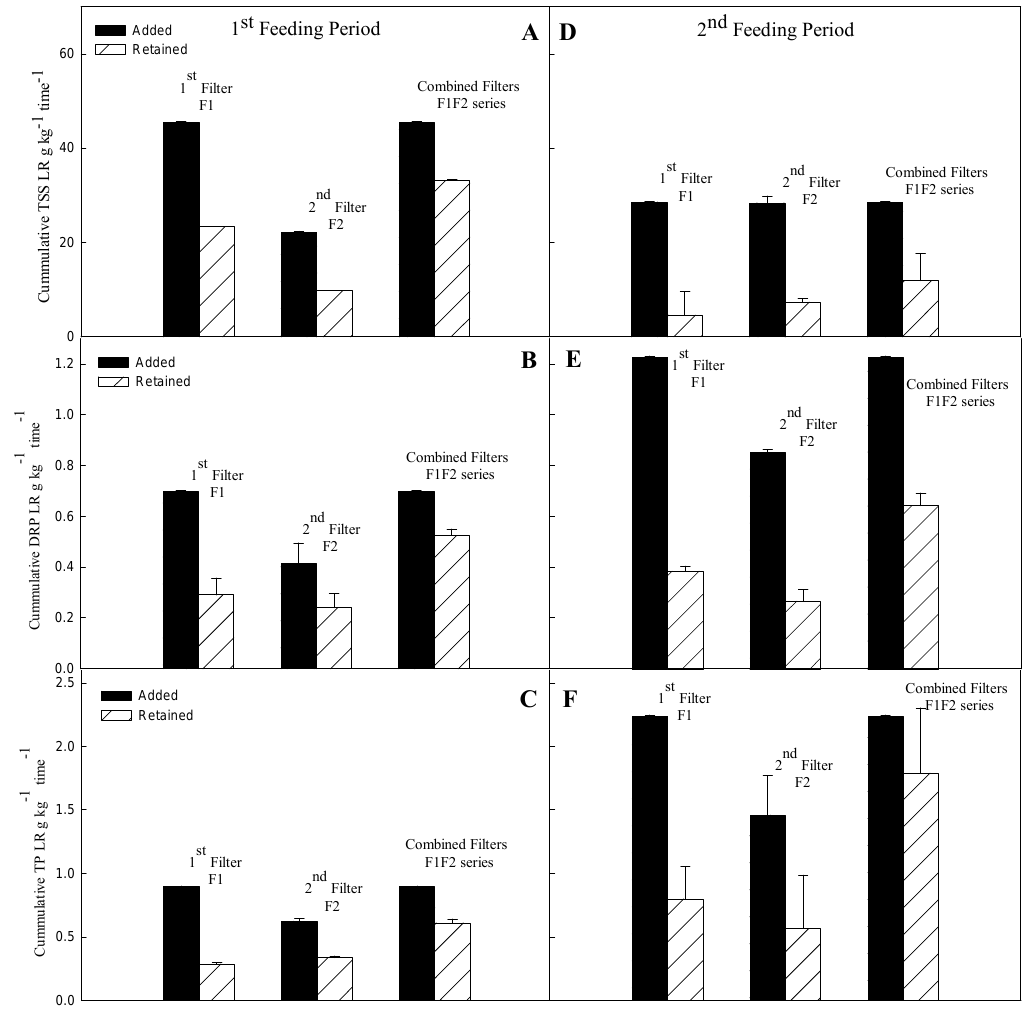
Figure 2. Cumulative total suspended solids (TSS)(A, D), dissolved reactive phosphorus (DRP)(B, E) and total phosphorus (TP) (C, F) loading rates to the filters during the first 52 day feeding cycle (A, B, C) and during the second 117 day feeding cycle (D, E,